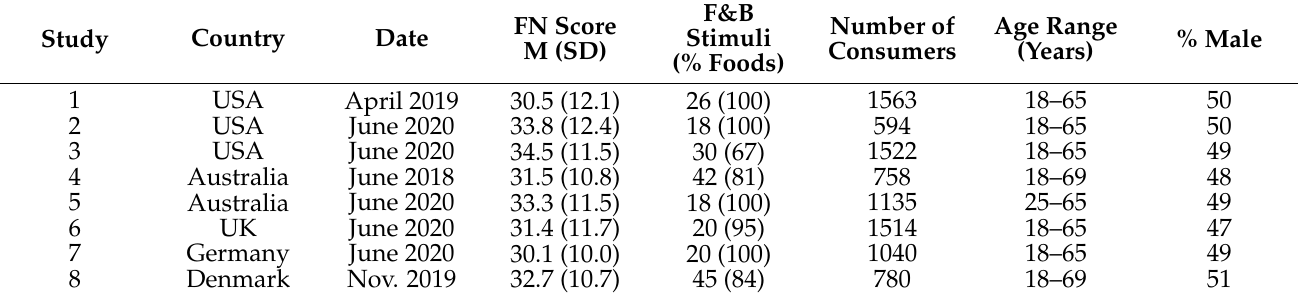
Table 1. Overview of studies included in the